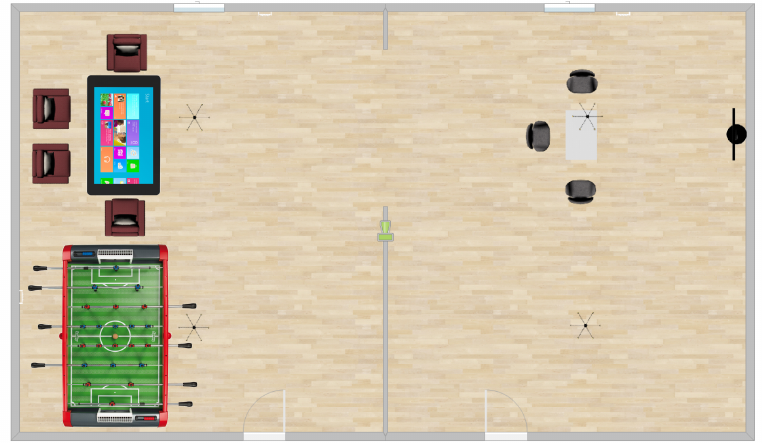
Figure 2. Ambient environment of Mines Douai.